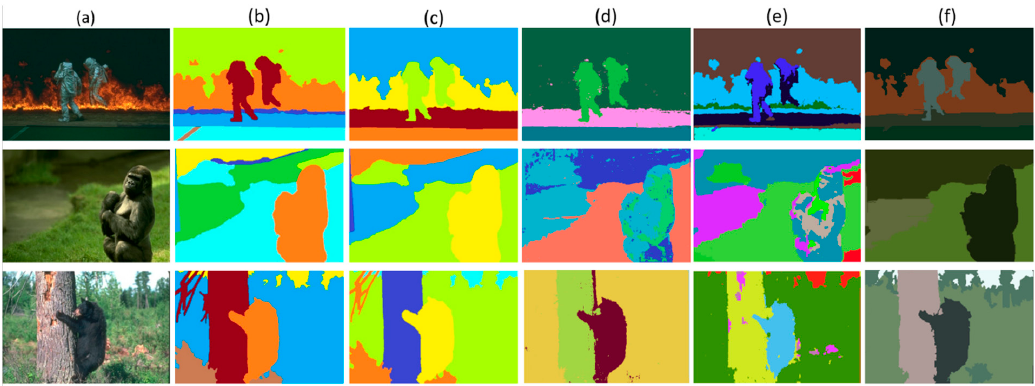
Figure 5. From left to right: ( a ) original images ( b ) and ( c ) ground truths provided by different annotators, ( d ) and ( e ) segmentation results of the algorithm of [42] with Felzenswalb and SLIC, respectively, ( f ) segmentation results of proposed algorithm.